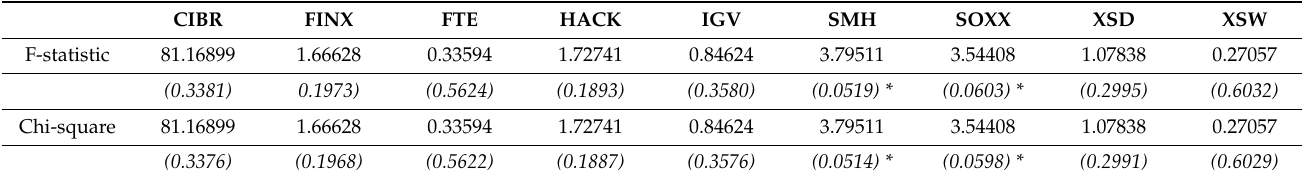
Table A9. WALD Test for the